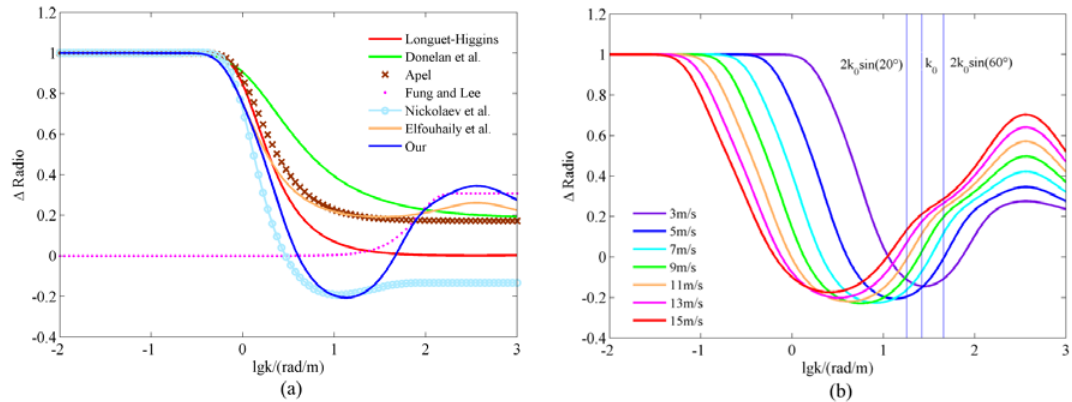
Figure 2. ( a ) Comparison of Δ ratios for several already-developed angular spreading functions (ASFs) and our ratio at a 5 m/s wind speed; ( b ) Our Δ ratio for wind speed from 3 m/s to 15 m/s with a 2 m/s interval.